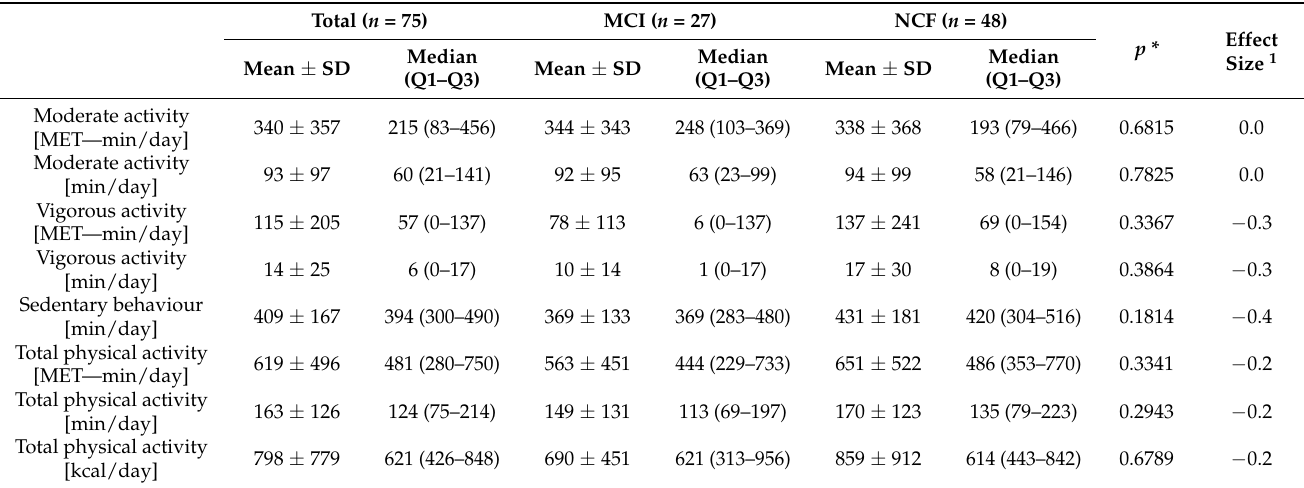
Table 3. Physical activity results assessed by the IPAQ in the study